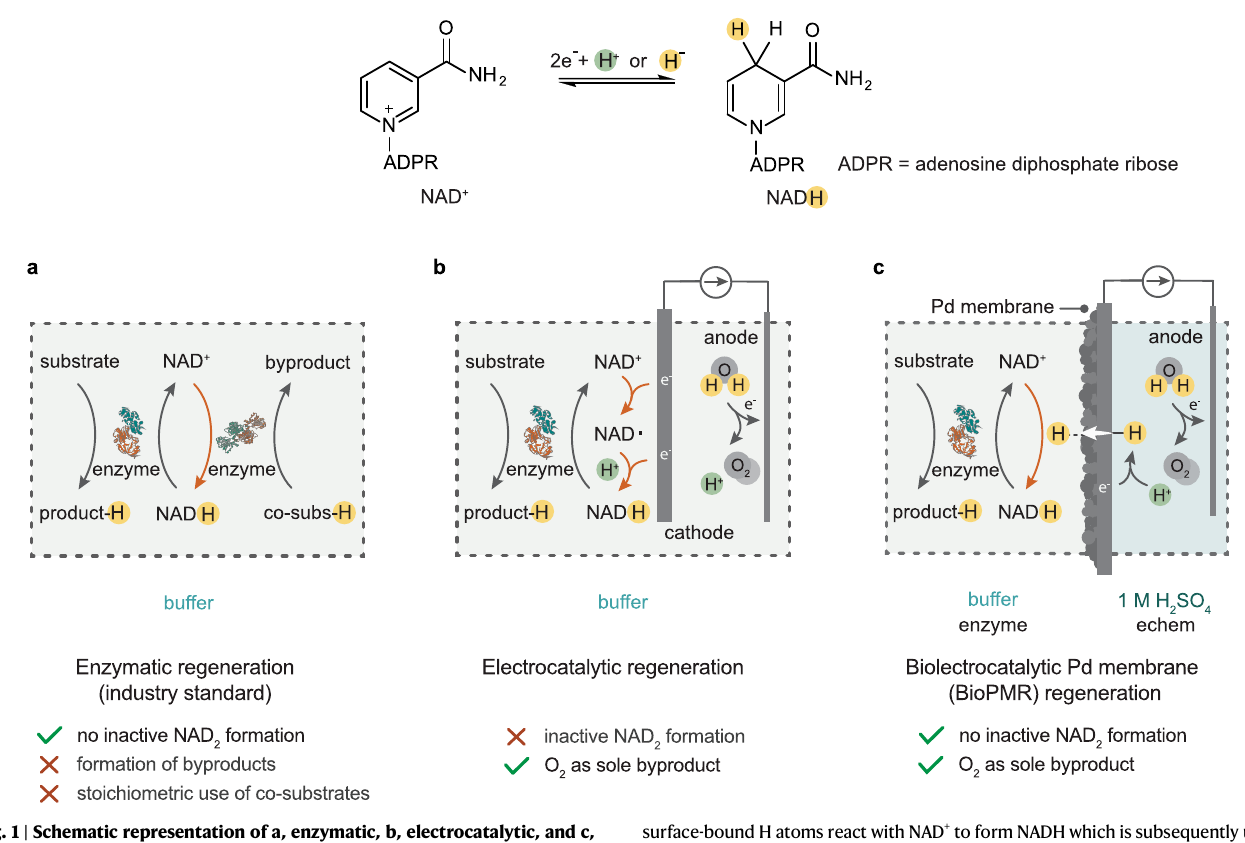
surface-bound H atomsreact withNAD + to formNADHwhichissubsequently used forenzymecatalysis.OrangearrowsindicatetheNADHregenerationstep(s)ineach